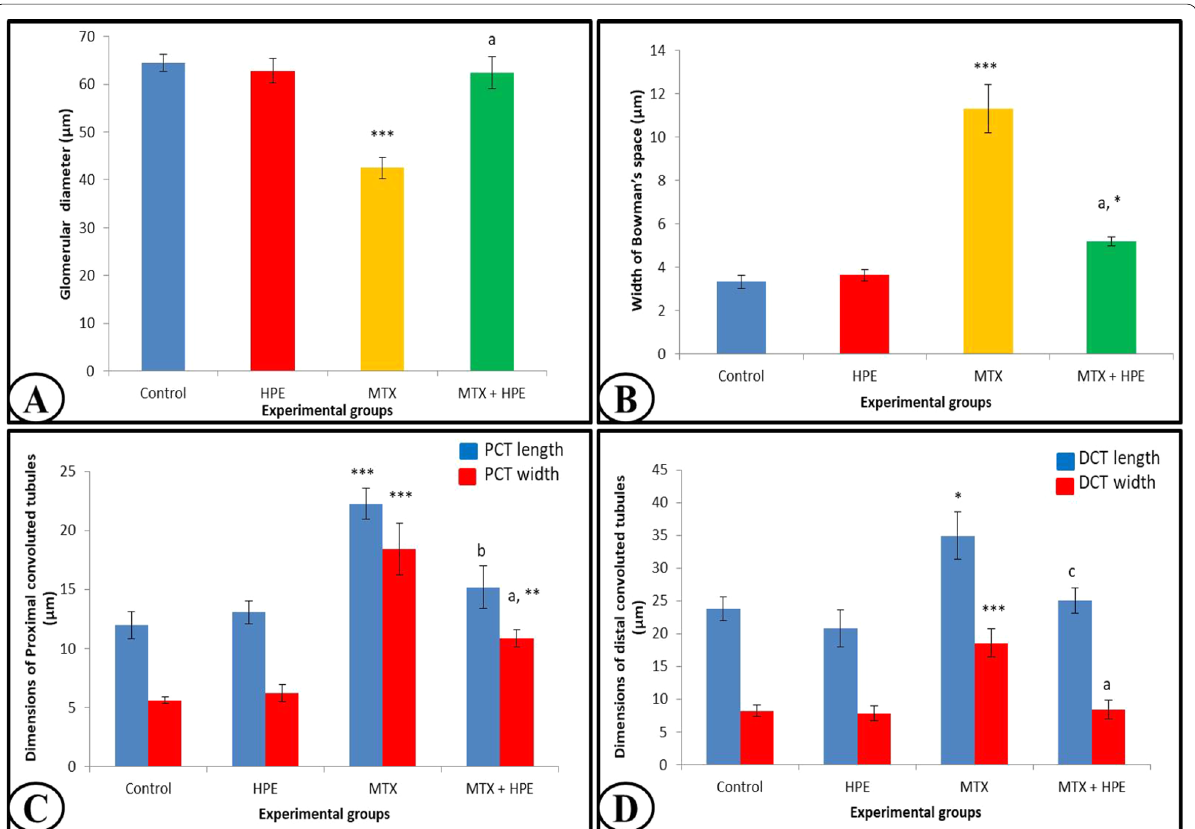
Fig. 3 Morphometric measurements of ( A ) glomerular diameters, ( B ) width of Bowman’s spaces, ( C ) dimensions of proximal convoluted tubules and ( D ) dimensions of distal convoluted tubules of animals of the different experimental groups. (***): highly significant at p < 0.001 compared with the control group.(**): significant at p < 0.01 compared with the control group. (*): significant at p < 0.05 compared with the control group. (a): highly significant at p < 0.001 compared with MTX group. (b): significant at p < 0.01 compared with MTX group. (c): significant at p < 0.05 compared with MTX